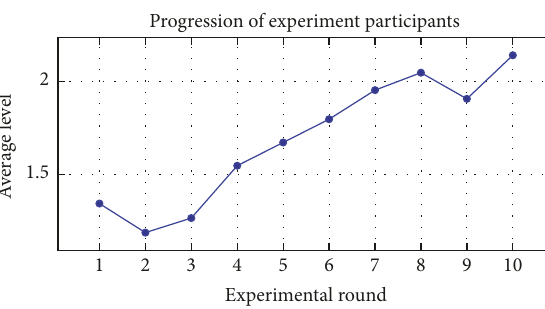
Figure 2: The figure plots the average level implied by the quantities chosen by participants in each round in the experiment. Quantities arecoded asper Table 3, except that theNash equilibrium quantityis coded as level-5; Collusive and Walras quantities are coded as level-